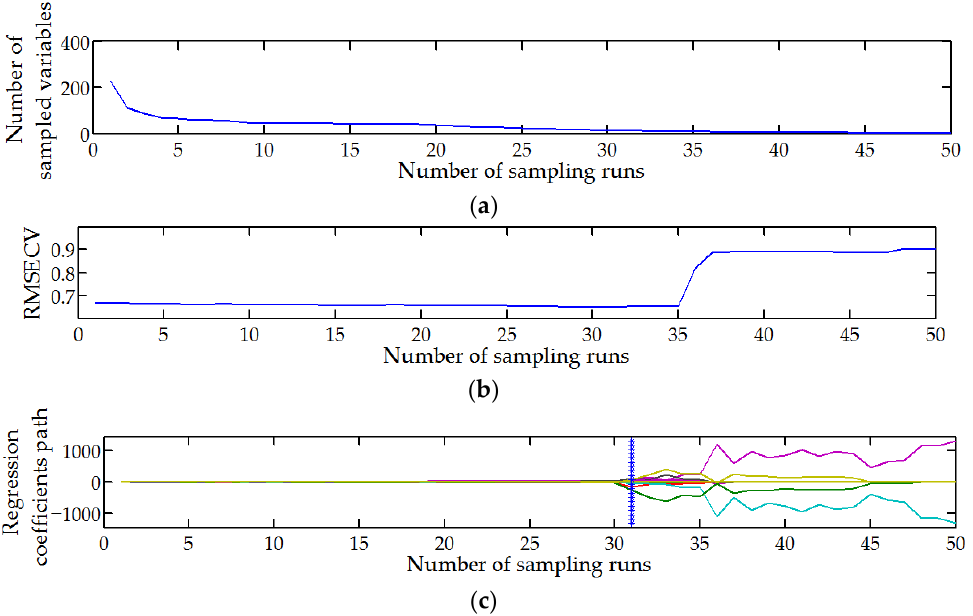
Figure 6. Characteristic wavelengths selection by CARS: ( a ) Number of sampled variables; ( b ) RMSECV values; ( c ) Regression coefficients of each wavelength variable.